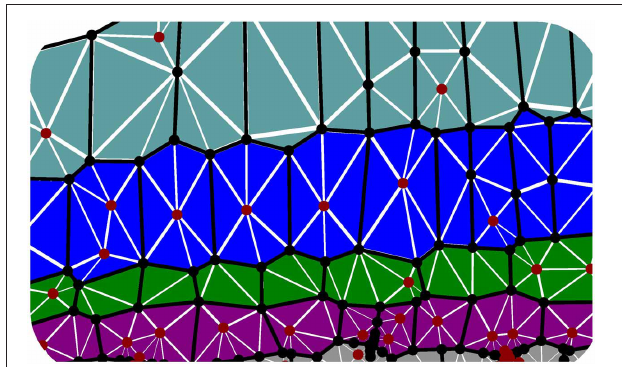
FIGURE 3 | Triangulated cell walls in the plane of the simulation. Edges of cells in the plane (axial or cross walls) are shown as heavy black lines; vertices are shown as black or red circles. Note that vertices may lie in the interior of cells (red circles); these are required to avoid using triangles with large aspect ratio in the initial configuration. As the tissue elongates, triangle aspect ratios increase, and either a more highly refined triangular mesh or periodic remeshing is required to accurately simulate organ bending (see Figure 6